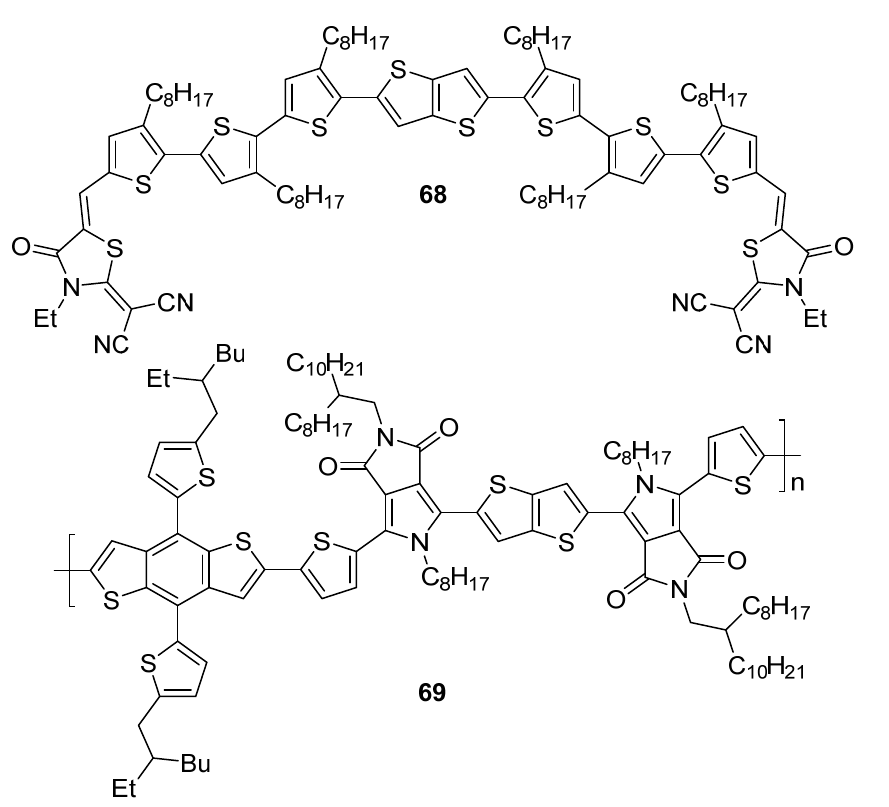
Figure 6. Examples of thieno[3,2- b ]thiophene derivatives applied in BHJ solar cells. Table 5. The optoelectronic properties of derivatives 68 – 72 applied in BHJs.